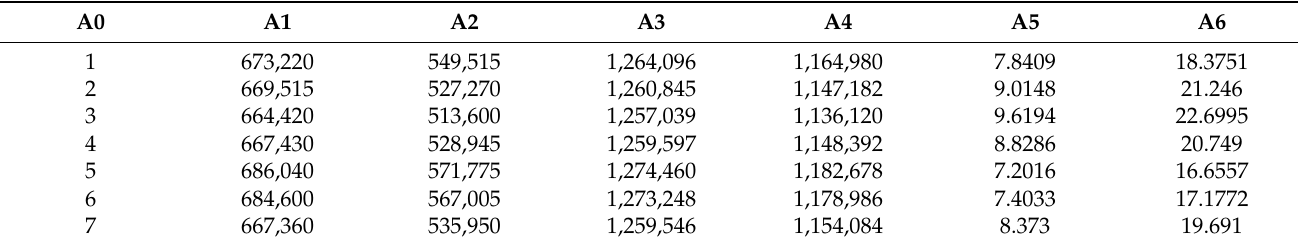
Table 1. Comparison of the transitions before and after Delta